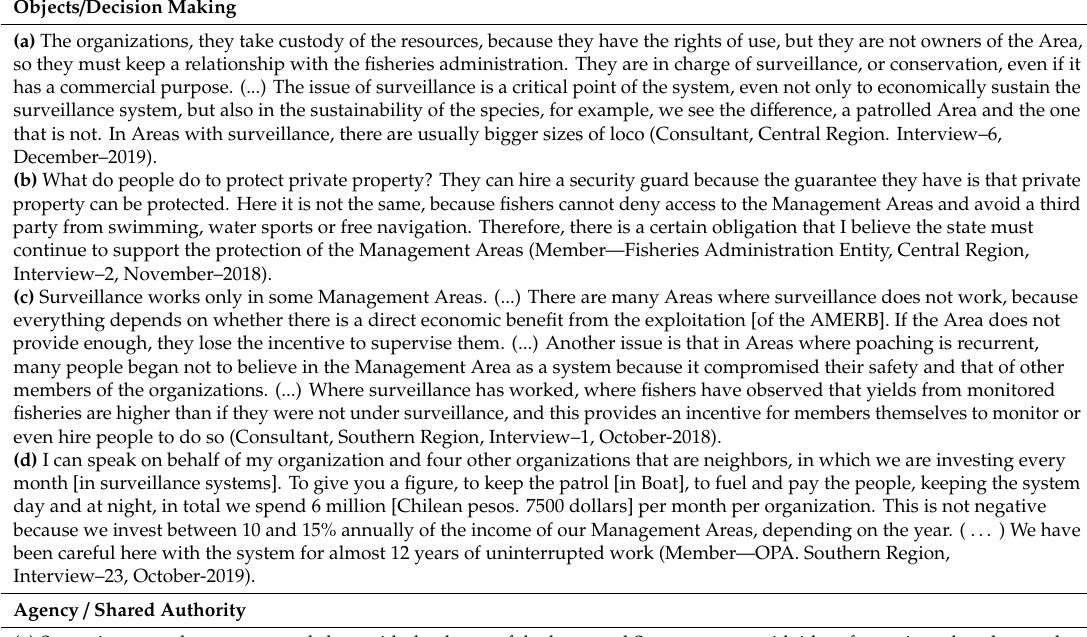
Table 2. Selected quotes from the